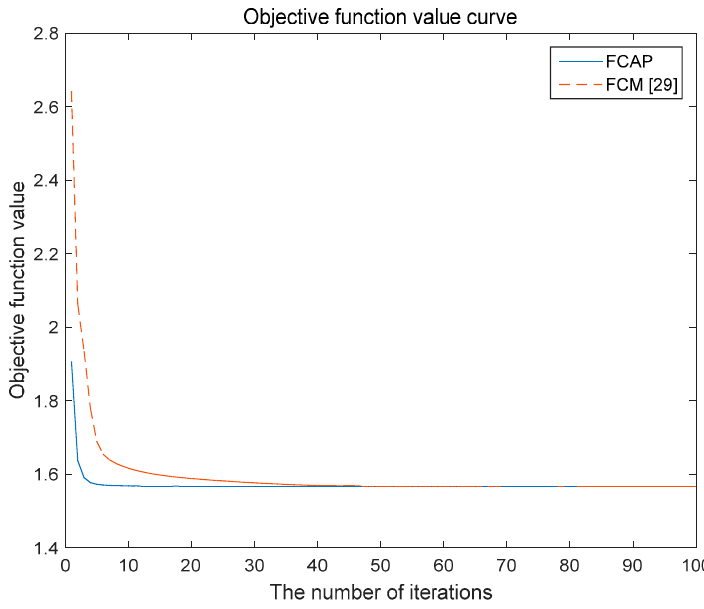
Figure 6. Objective function value curve for the simulated resource data set.